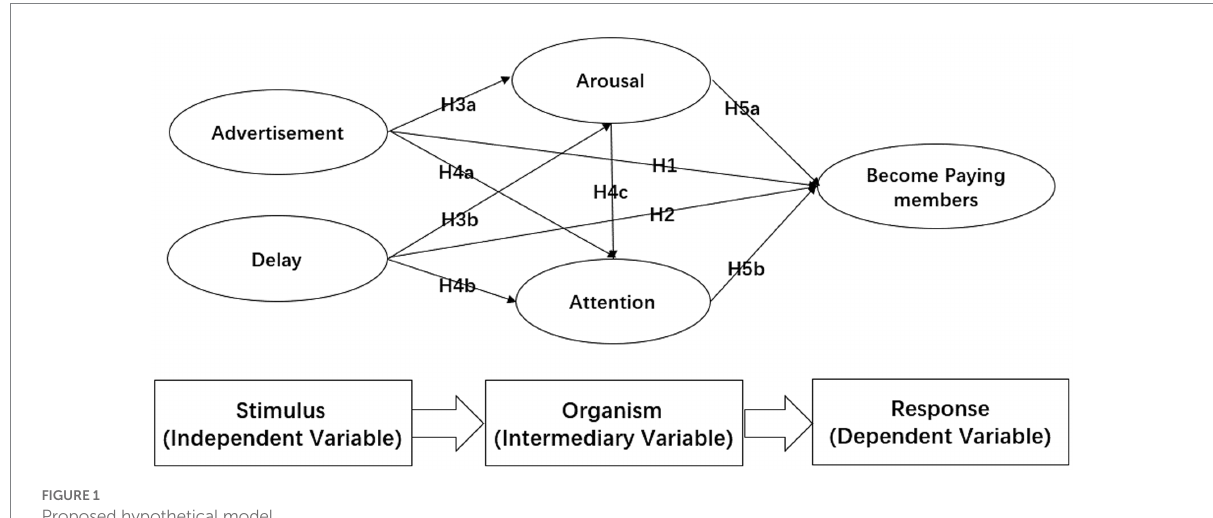
FIGURE 1 Proposed hypothetical model.